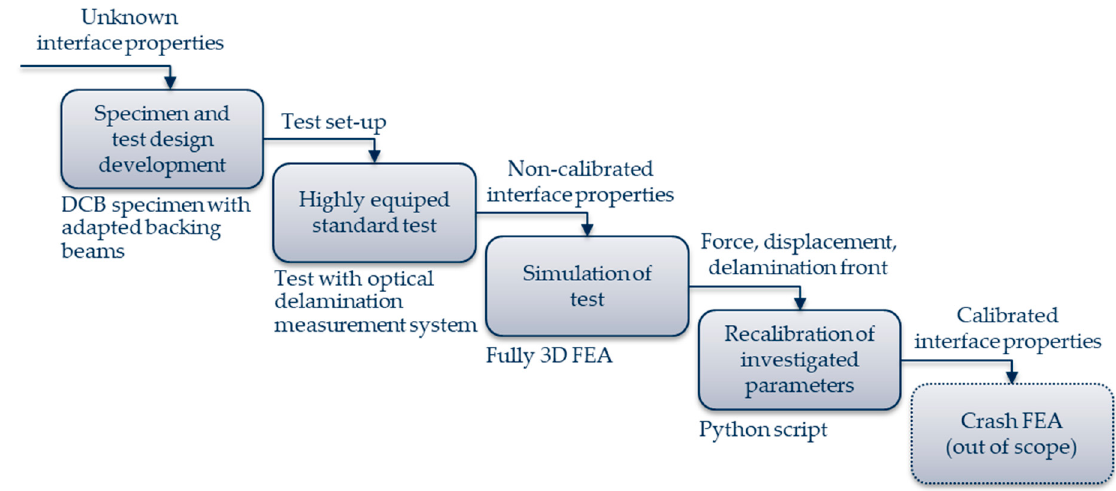
Figure 2. Numerical-experimental approach to determine the interface properties of high-performance metal-polymer interface.